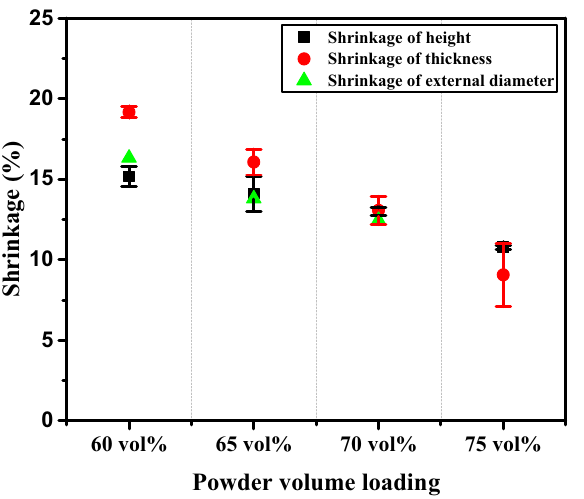
Figure 11. Dimensional shrinkage of sintered specimens as a function of powder loading. The measurement of the shrinkage in height, thickness and external diameter was done five times for each sample.